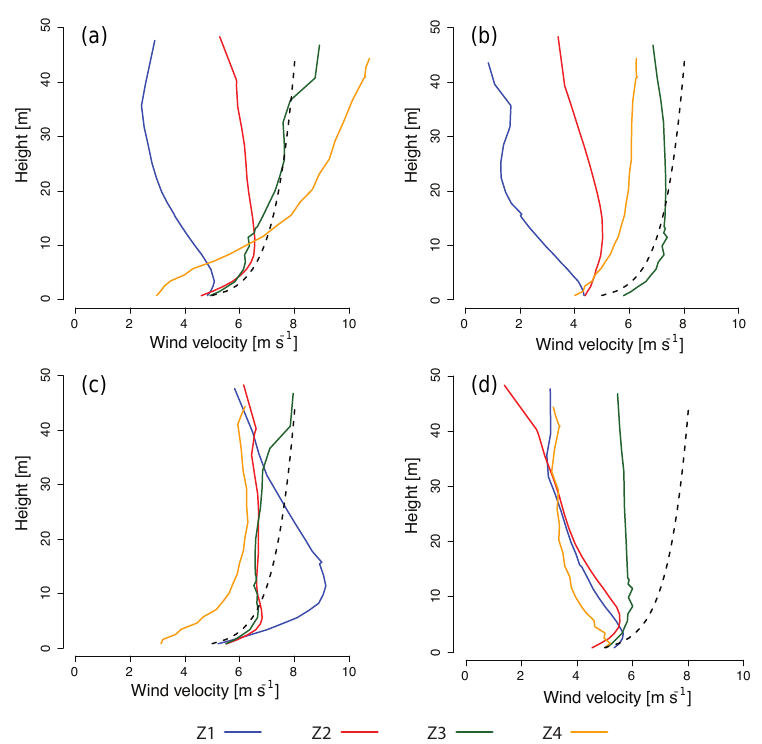
Figure 4. Vertical profiles of the mean wind velocity at the four sites (Z1, Z2, Z3 and Z4) for each case experiment. The dashed line represents a neutral logarithmic wind profile with z 0 = 0 . 01m and u ∗ = 0 . 3ms − 1 .